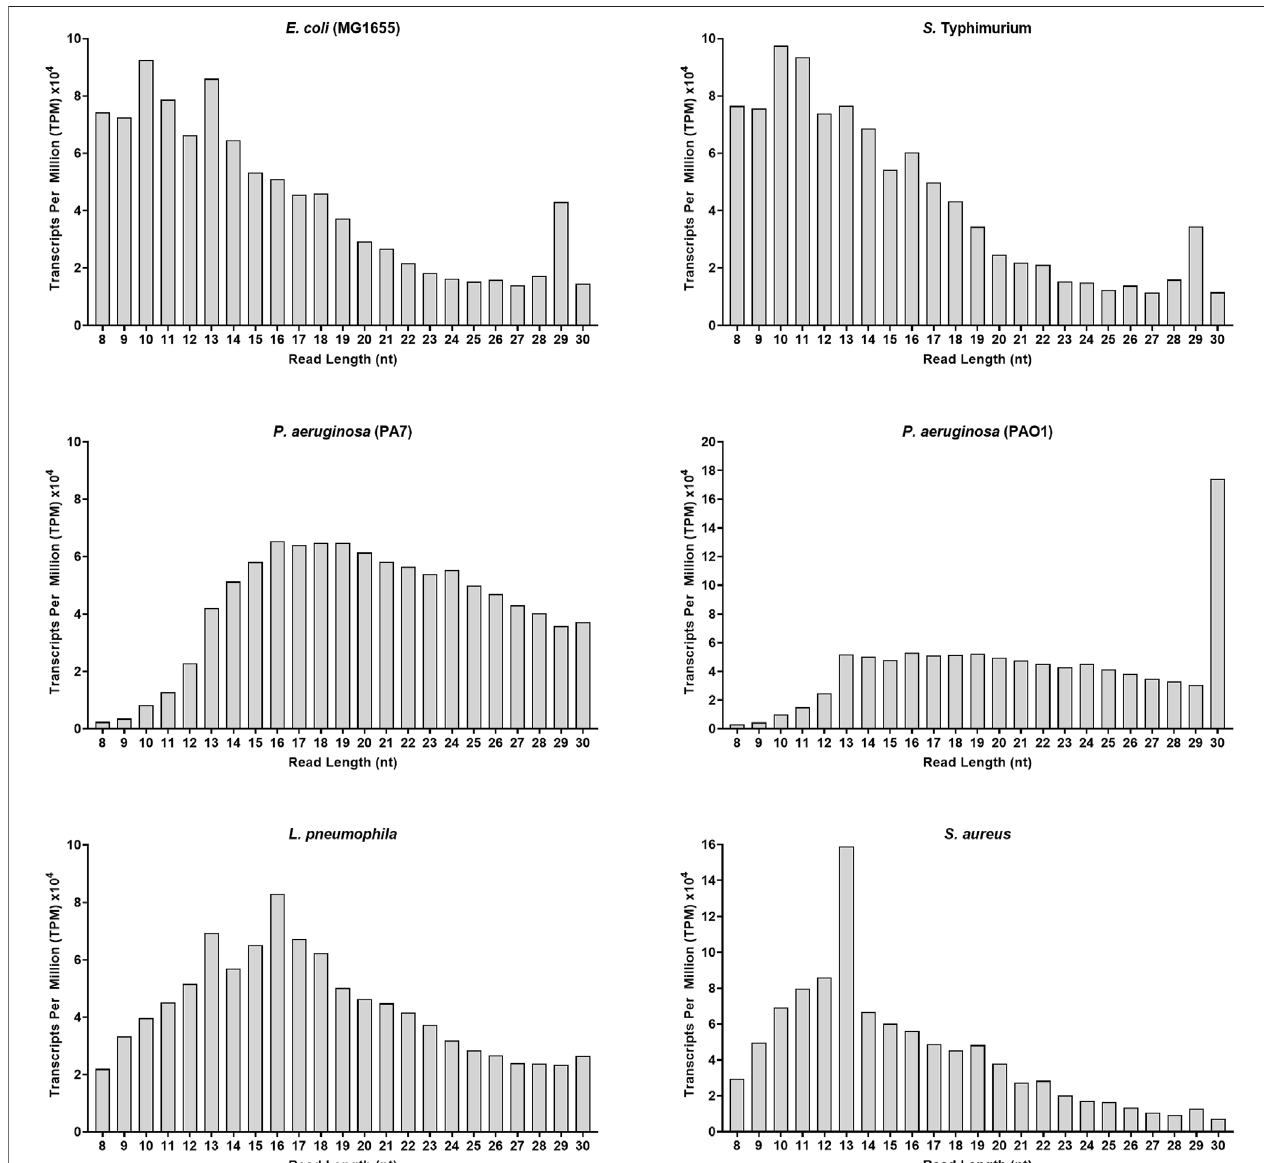
FIGURE 1 | Adapter-trimmed reads length (8 – 30 nt) distribution in different bacterial strains. Small RNA-Seq analyses in the 8 – 30 nt window of six bacterial samples. Total adapter-trimmed reads counts were expressed in TPM. The details of the technical approach are described in the section of Materials and Methods .